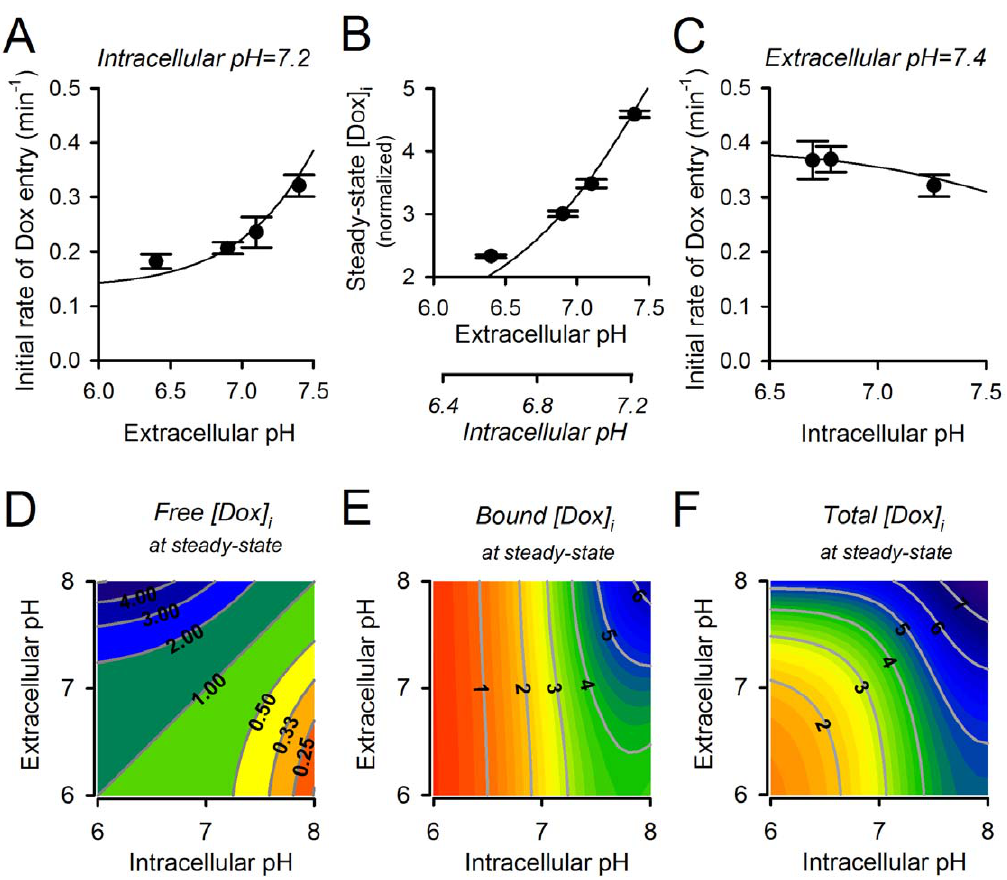
Figure 3. Effect of intracellular and extracellular pH on drug uptake and accumulation. (A) Initial rate of doroxubicin uptake, measured at constant intracellular pH, over a range of extracellular pH values (data from Fig. 2A) with best-fit. (B) Intracellular doxorubicin at steady-state, normalized to extracellular concentration, over a range of extracellular pH values. Secondary axis plots steady-state pH i attained at given pH e . (C) Initial rate of doxorubicin uptake, measured at constant extracellular pH, over a range of intracellular pH values (data from Fig. 2B) with best-fit. Model predictions for the steady-state relationship between intracellular pH, extracellular pH and either (D) free, (E) bound or (F) total doxorubicin. Contour labels denote total intracellular doxorubicin concentration, normalized to its extracellular concentration (50 m M).